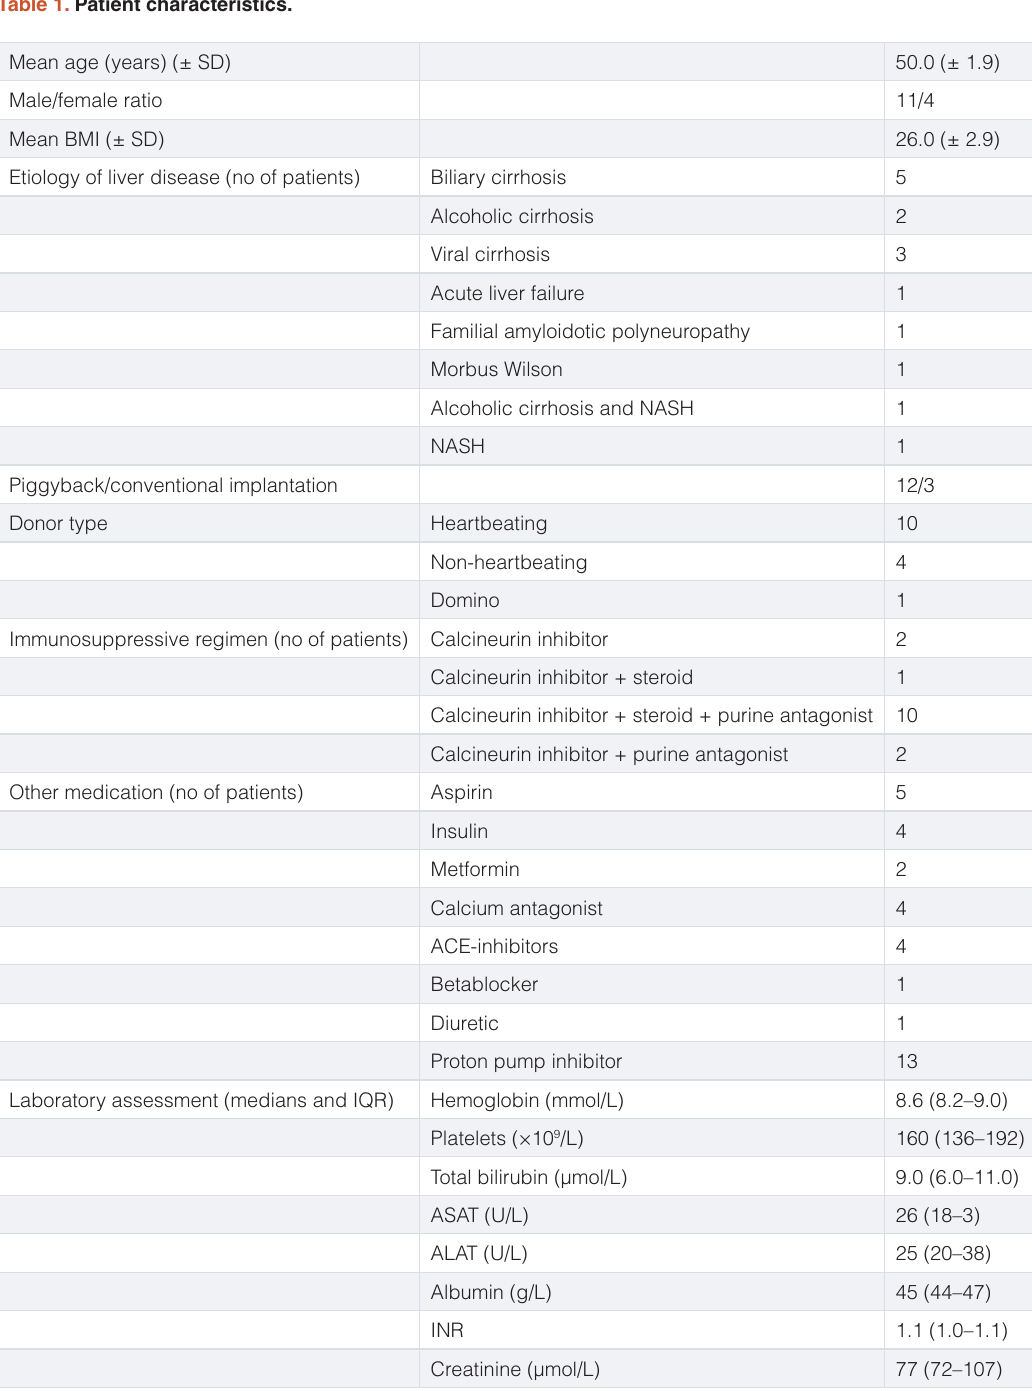
Table 1. Patient